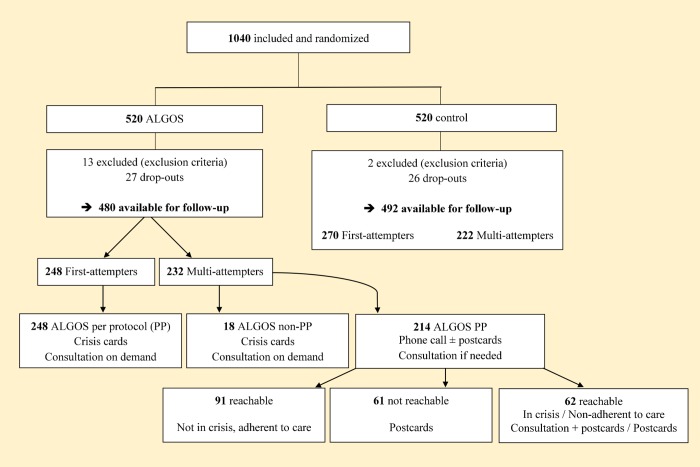
Study flowchart.